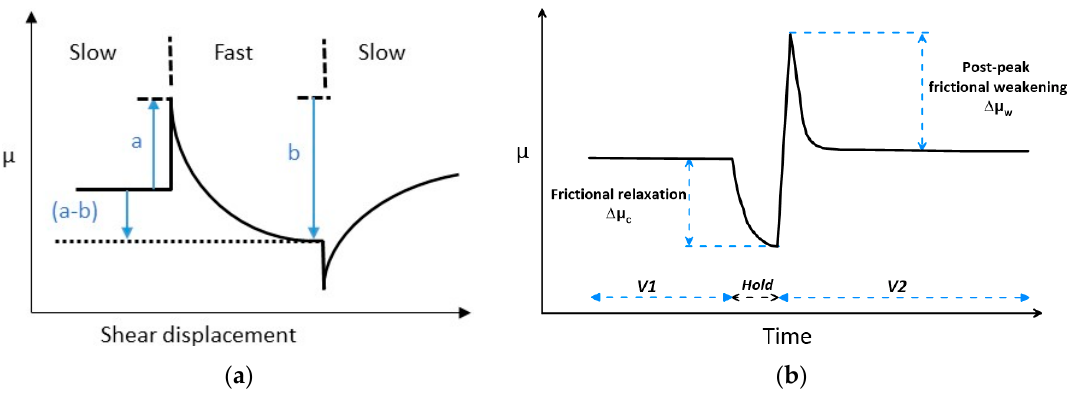
Figure 2. ( a ) A simplified rate-and-state friction model (modified after [22]). Negative values of ( a − b ), as illustrated here, indicate velocity-weakening of the material, and implies generation of seismicity in case of a slip. Positive ( a − b ) values indicate velocity-strengthening behaviour and imply aseismic movement during a slip. ( b ) Schematic presentation of frictional relaxation, and post-peak frictional weakening (modified after [12]).